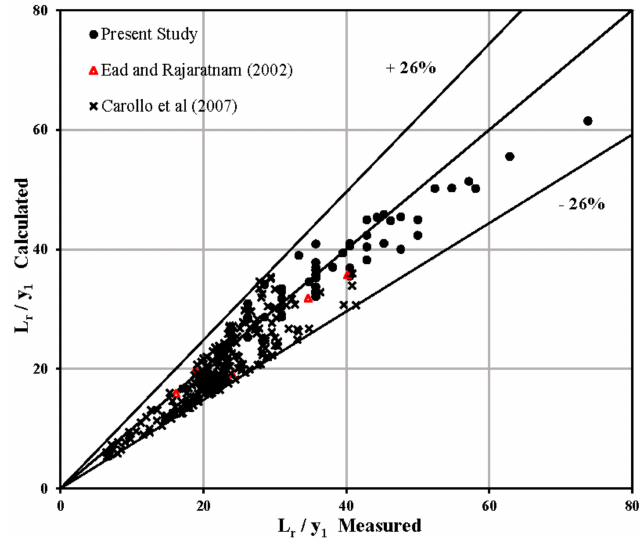
Figure 10. Comparison between the measured values of the ratio L r / y 1 and those calculated by Equation